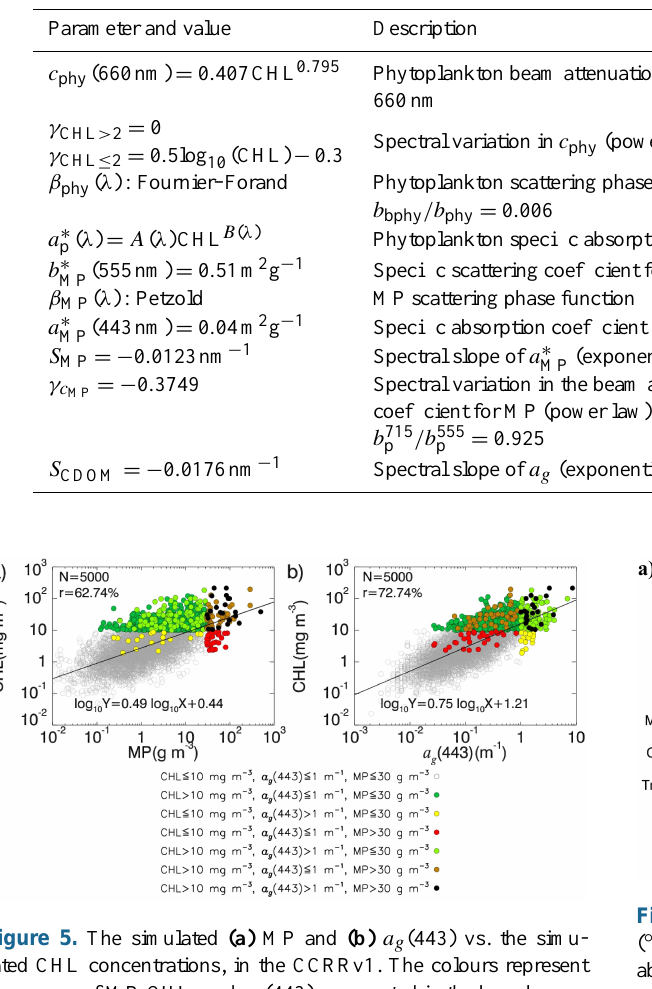
Table 11. The inherent optical properties as established in CCRRv1.